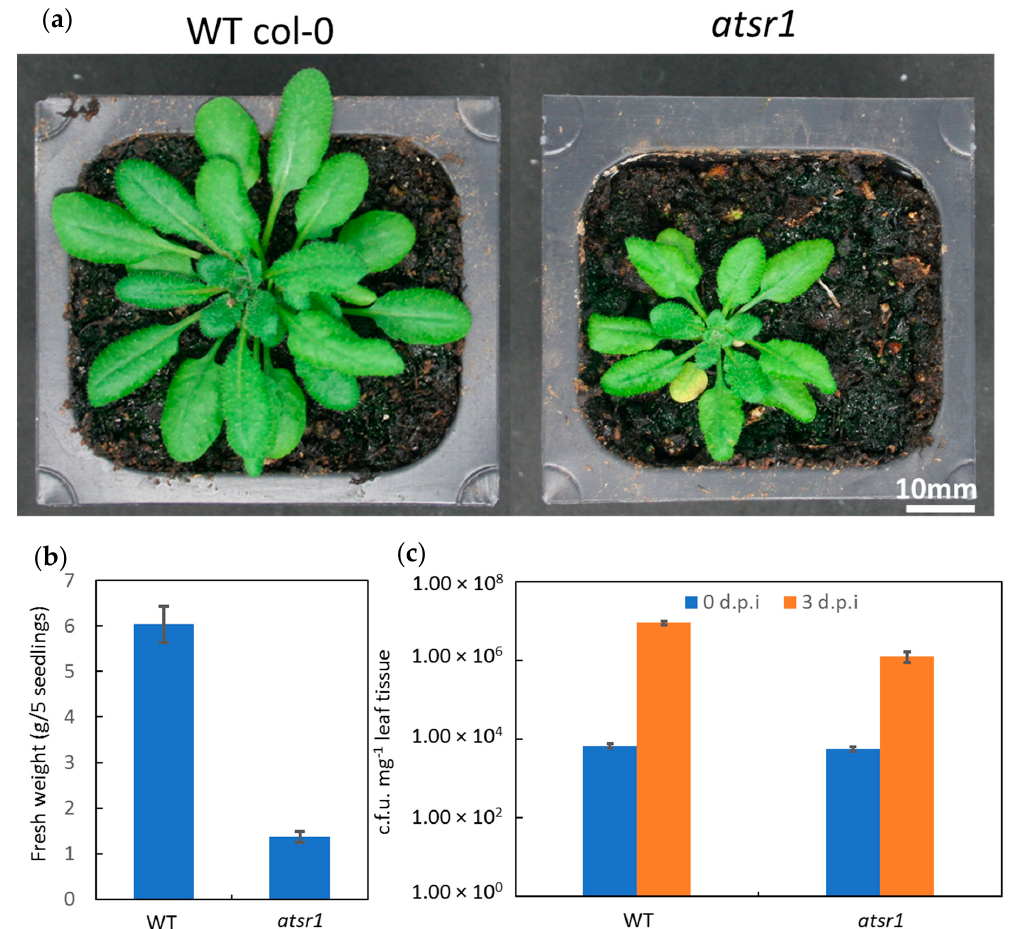
Figure 1. Arabidopsis Signal Responsive 1 (AtSR1) is involved in plant immune response as well as growth and development. ( a ) Phenotypic comparison. Five-week-old wild-type (WT) and the atsr1 loss-of-function plants were grown at 20–22 °C under a 12 h photoperiod. Scale bar represents 10 mm. ( b ) Growth comparison. Fresh weight of rosettes was calculated from five-week-old WT and the atsr1 loss-of function mutant were grown at 20–22 °C under a 12 h photoperiod . Values are means ±SD ( n = 5). ( c ) Disease resistance test for WT and atsr1 . Rosette leaves of five-week-old Arabidopsis were infiltrated with Pst DC3000 (OD 600 = 0.001), and the number of colony-forming units (cfu) was calculated at zero (1 h after inoculation) and three days post-inoculation (dpi). Values are means ± SD ( n =